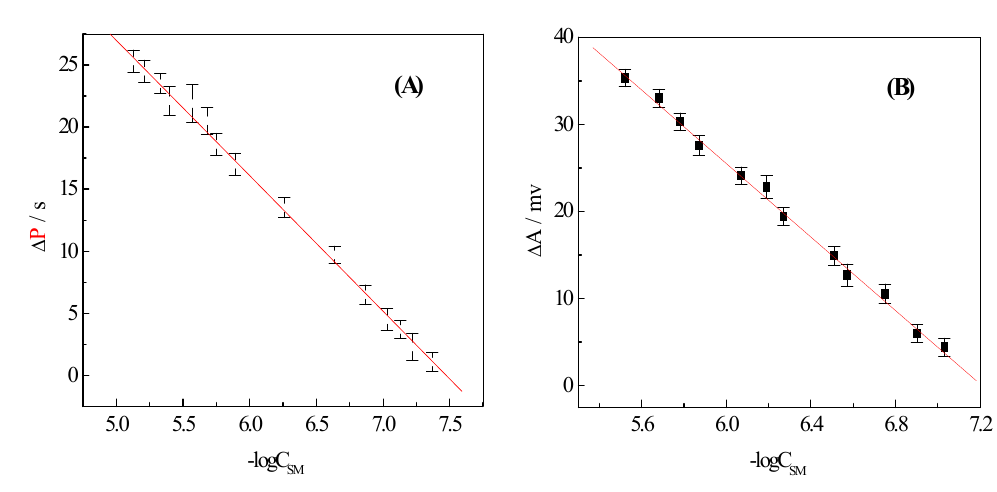
Fig. 4 Calibration curve of changes in period (A) and in amplitude (B) versus the negative of logarithm of sulfanilamide concentration.